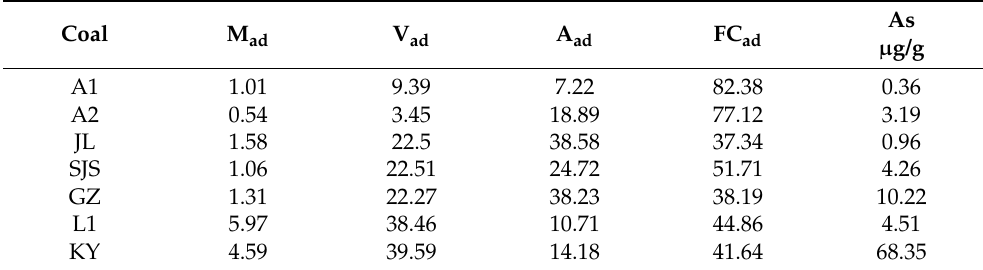
Table 5. Proximate and ultimate analysis, and arsenic concentration of coal samples